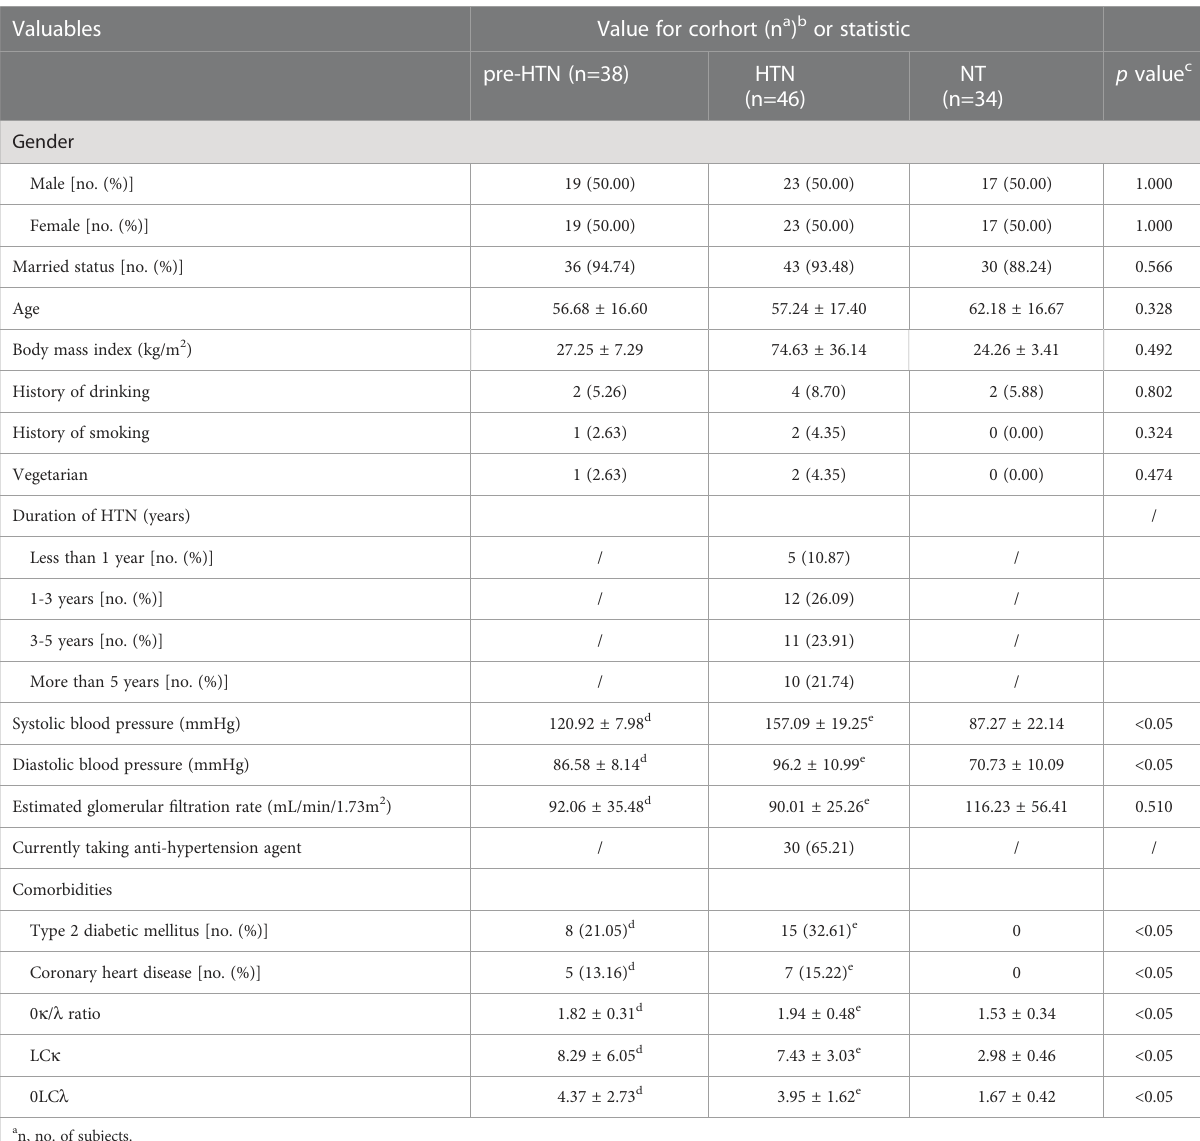
TABLE 1 Demographic and clinical characteristics of the study population.